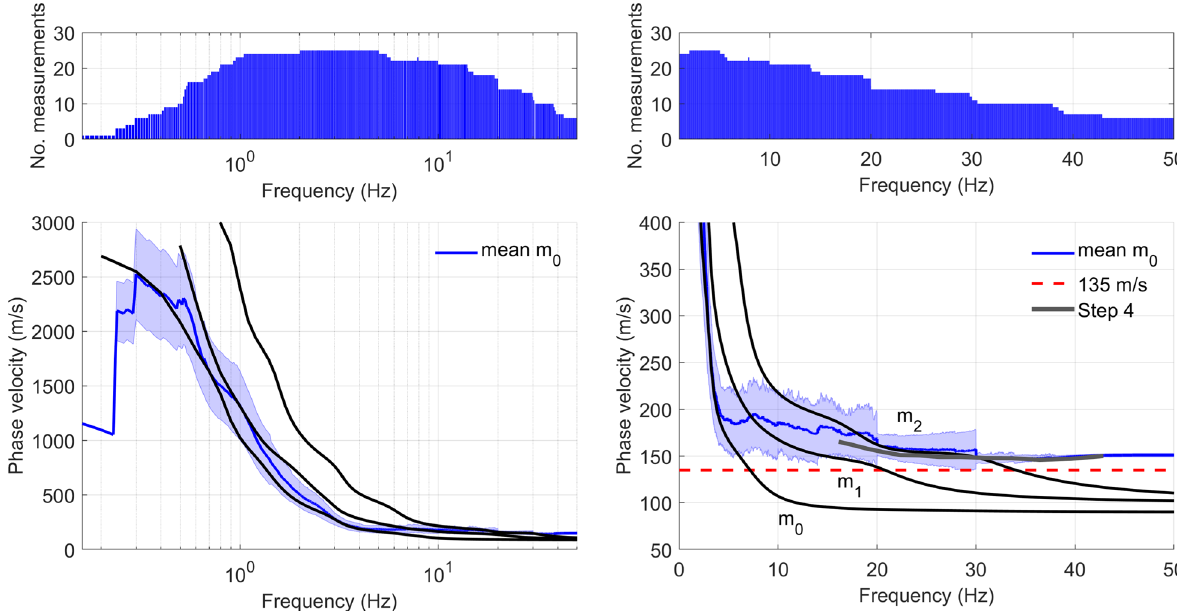
Fig. 8 Blind test summary; Comparison of the theoretical dispersion curves for the preferred model and the mean dispersion curve from all submitted data to this blind